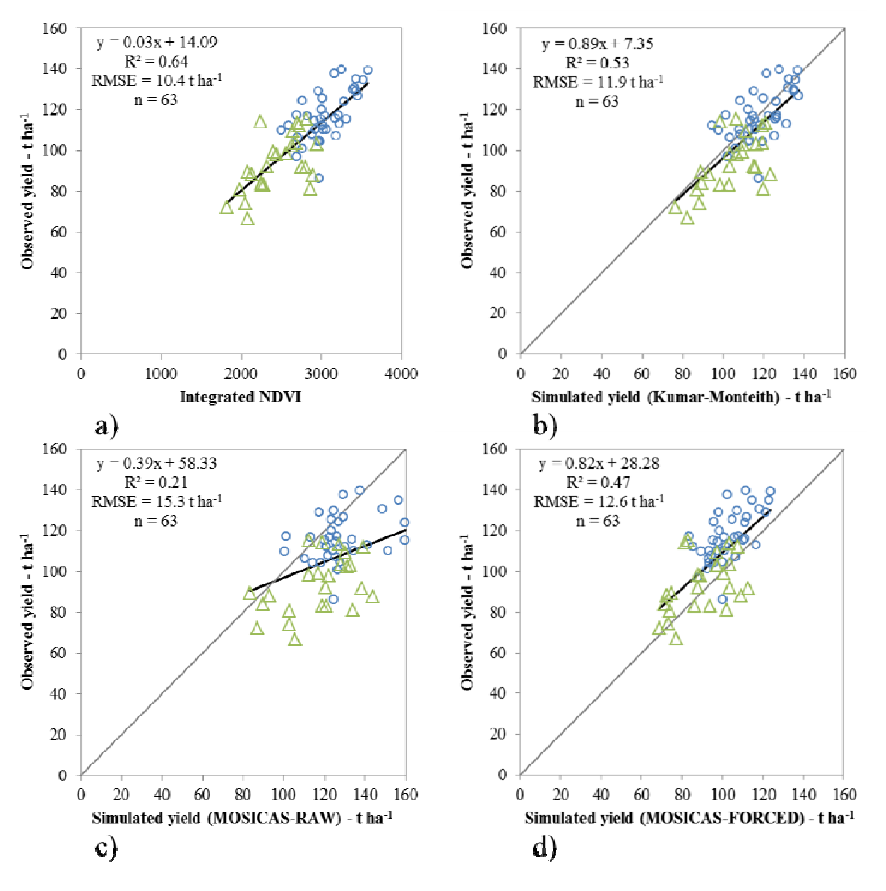
Figure 5. Comparison of the yield estimation accuracy of the methods: ( a ) empirical NDVI; ( b ) Kumar-Monteith model; ( c ) MOSICAS RAW; and ( d ) MOSICAS-FORCED. Blue circles represent the fields located in the northern site, green triangles represent the fields located in the southern